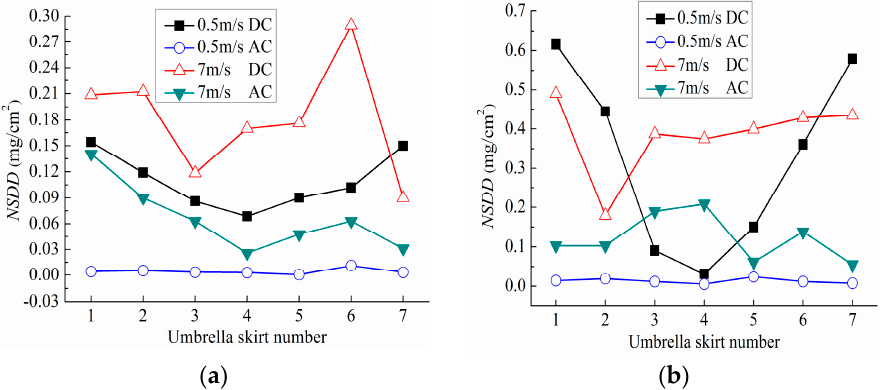
Figure 11. Distribution law of the contamination along the porcelain bell jar insulator skirt, ( a ) d p =10 μ m; and ( b ) d p =20 μ m.